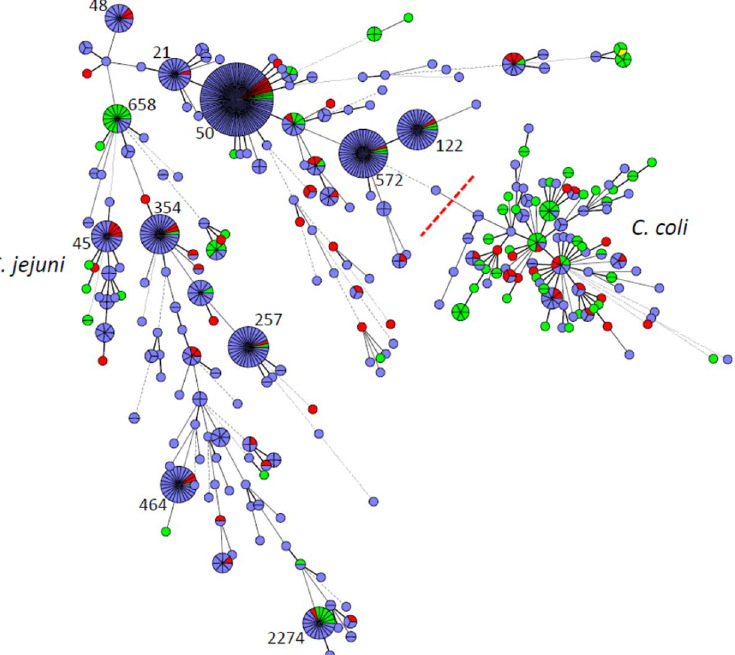
Figure 1. Minimal Spanning Tree generated from MLST comparisons of 816 C. jejuni and C. coli isolates from human study participants and from animals and food samples from the study region. Colouring according to isolate source: blue, isolates from patients; green, isolates from animals; red, isolates from food samples. Only abundant sequence types (STs) are labelled. A version of the figure with full labelling is available as Supplementary Figure